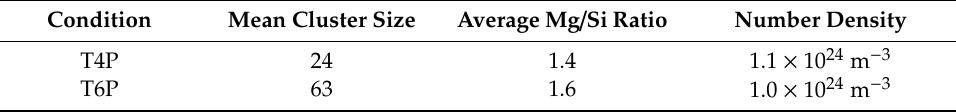
Figure 3 . APT analyses of Alloy Sn visualizing the 3D atom maps of Mg–Si co-clusters ( a , b ) in T4P and T6P conditions. The corresponding cluster size distributions and proxigrams are shown in ( c – f ). The different circle diameters in ( c ) and ( d ) indicate the cluster size. Table 3. Properties of the Mg–Si clusters of Alloy Sn in T4P and T6P conditions.